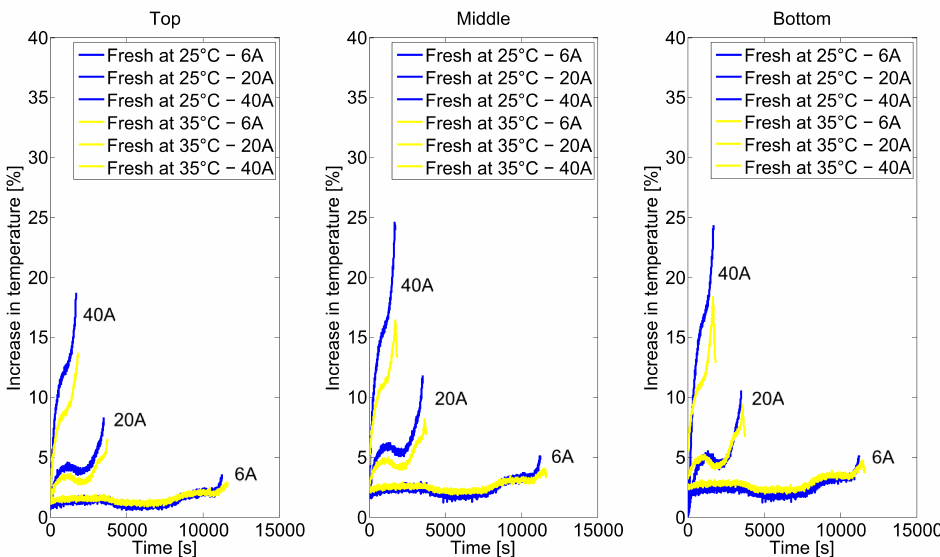
Figure 10. Temperature increase of the cell 1 at 25 ◦ C and 35 ◦ C under various current rates.